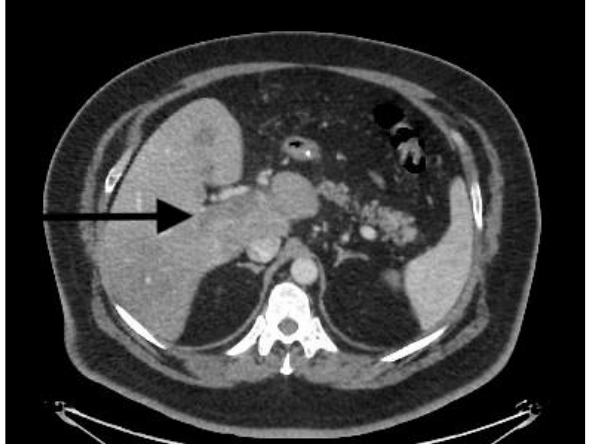
Figure 2. Portal thrombosis CT .